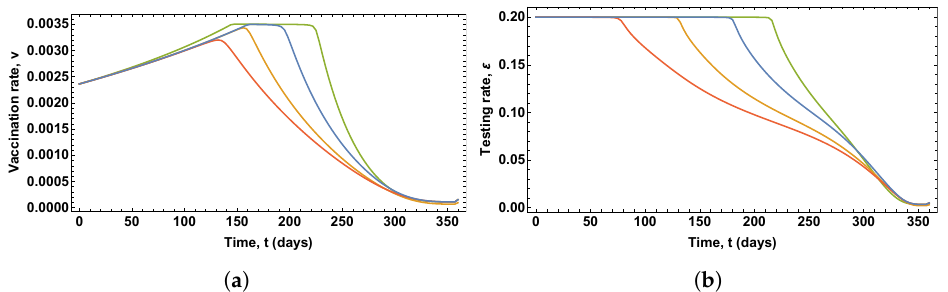
Figure 8. Optimal policies obtained assuming C 1 = 0.001 (red), C 1 = 0.01 (orange), C 1 = 0.1 (blue), and C 1 = 1 (green), with fixed parameters C 2 = 0.1 and C 3 = 0.0001: ( a ) Optimal vaccination rates. ( b ) Optimal testing rates.